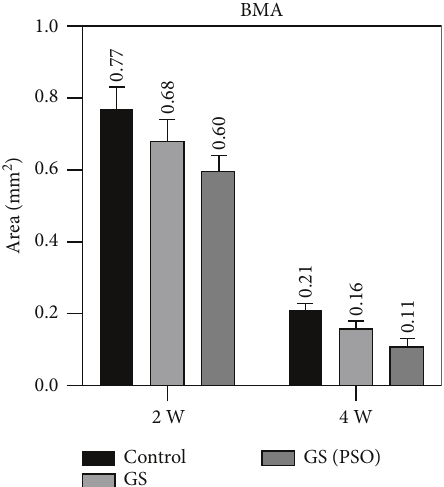
Figure 8: A bar chart representation of the mean and standard deviation of bone cells after 2- and 4-week time intervals for os- teoclast, considering the C, GS, and GS/PSO groups.